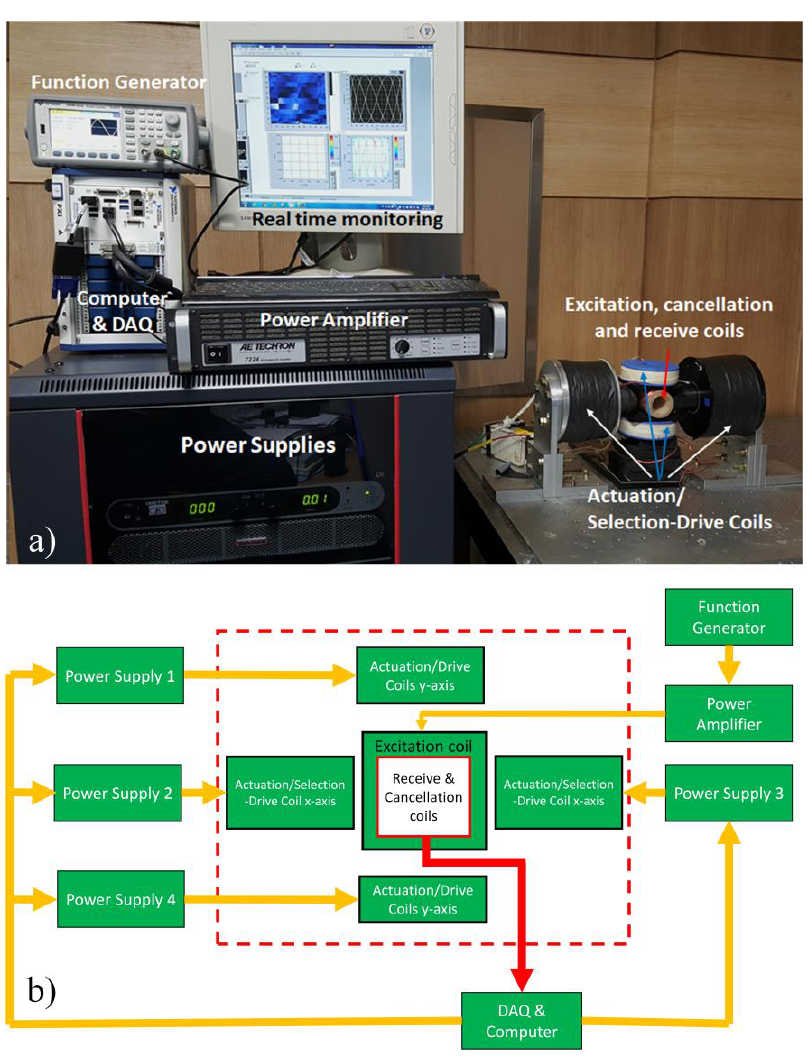
Figure 4. Two-dimensional real-time MNP imaging system. ( a ) System setup for 2D real-time MPI-based monitoring, ( b ) wiring scheme for the 2D MPI system. Table 1. Geometrical specifications of the coils in the 2D MPI system.